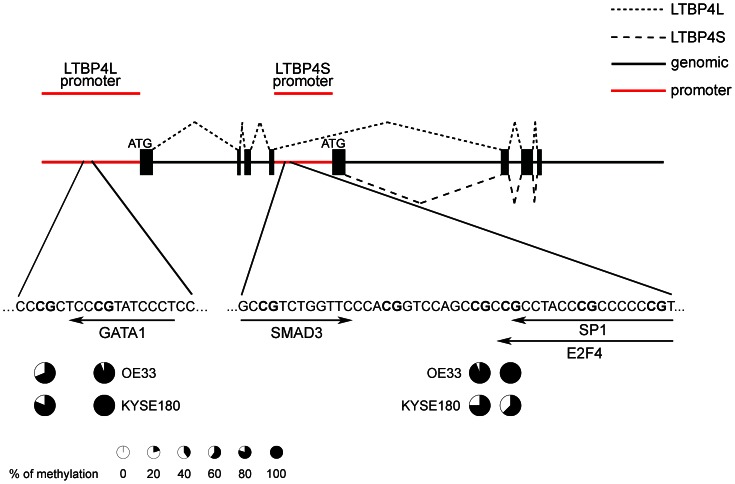
Identification of highly methylated binding sites for transcription factors in the LTBP4L and LTBP4S promoter.
In silico analysis of LTBP4 promoter sites identified a highly methylated binding site for GATA1 in the LTBP4L promoter of OE33 and KYSE180 cells. Highly methylated binding sites for SP1 and E2F4 are found in the LTBP4S promoter of both cell lines. A binding site for SMAD3 was identified nearby. The methylation status was analyzed by clonal bisulfite sequencing and at least ten clones were sequenced for each cell line. The percentage of methylation is visualized as pie chart. Exons are illustrated by black boxes and LTBP4S and LTBP4L promoters by red lines. The translation start sites are indicated (ATG). The dashed lines represent alternative splicing of LTBP4.